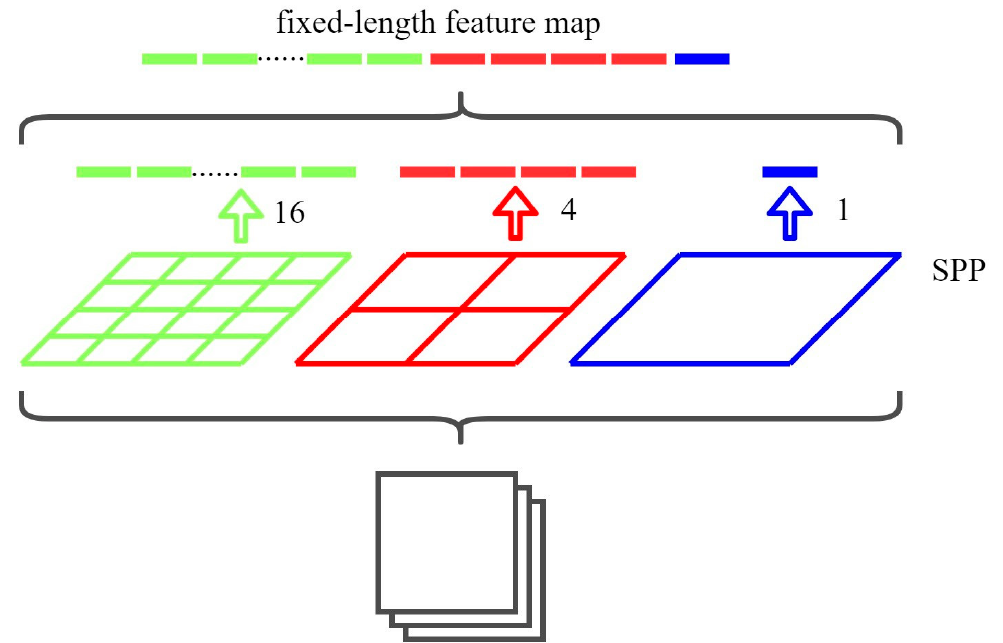
Figure 6. Original spatial pyramid pooling (SPP) structure in the SPP net.